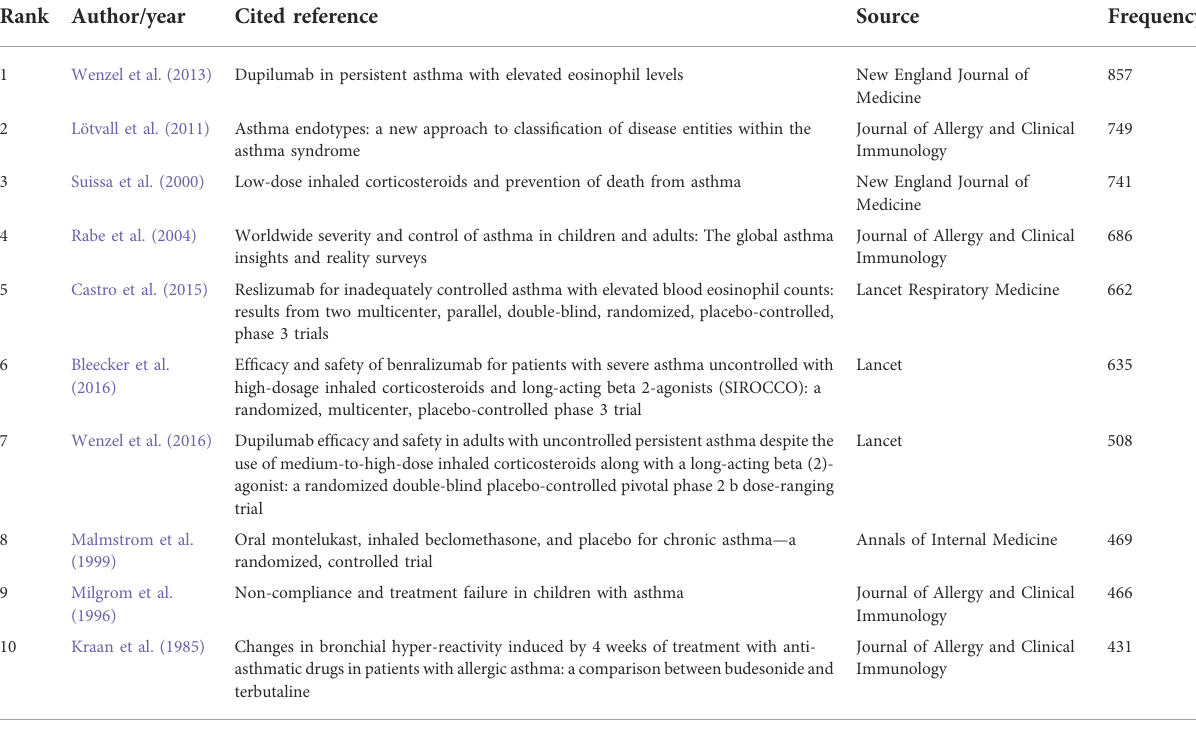
TABLE 7 Top 10 cited references in asthma drug-related